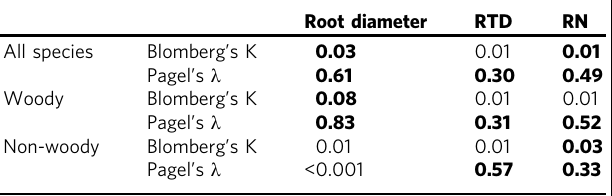
Bold values indicate signi fi cant phylogenetic signals ( p